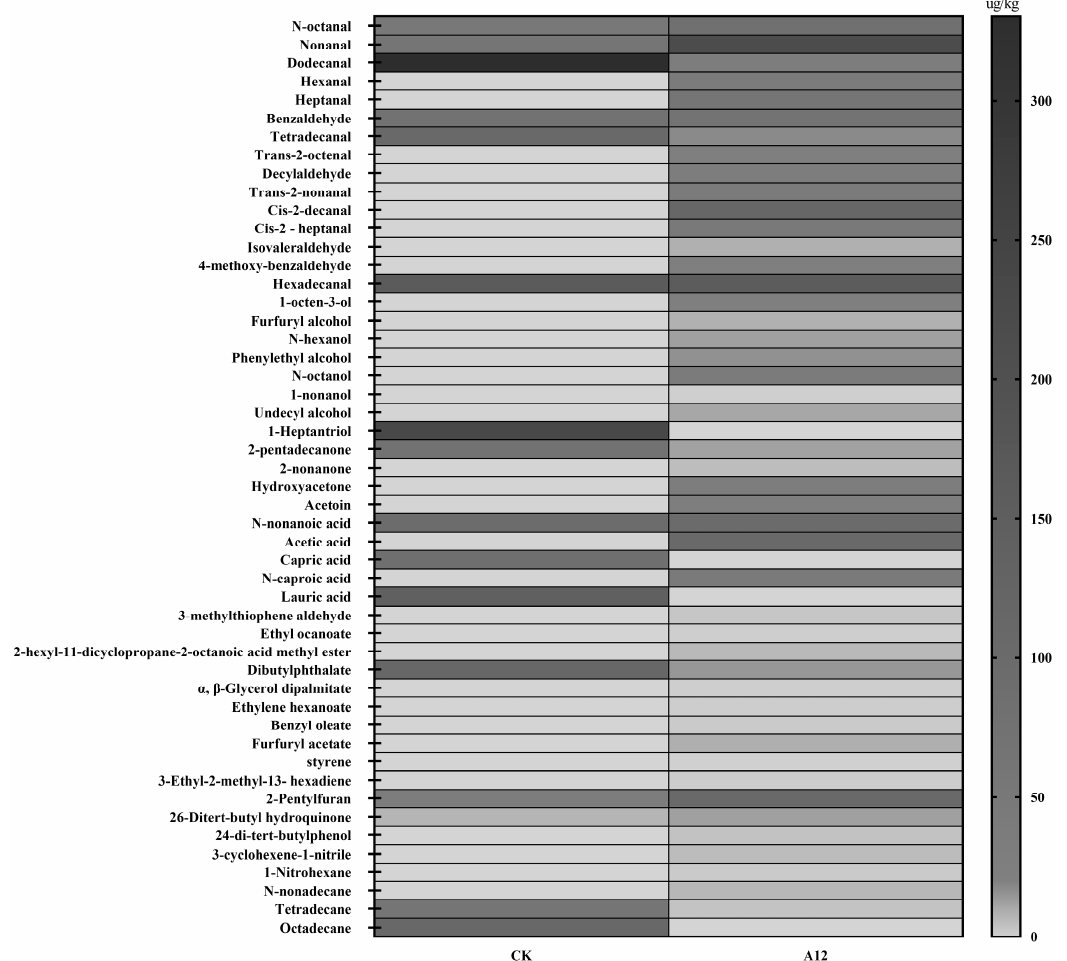
Figure 2. Effect of Bifidobacterium animalis on volatile flavour components of fermented sausage.